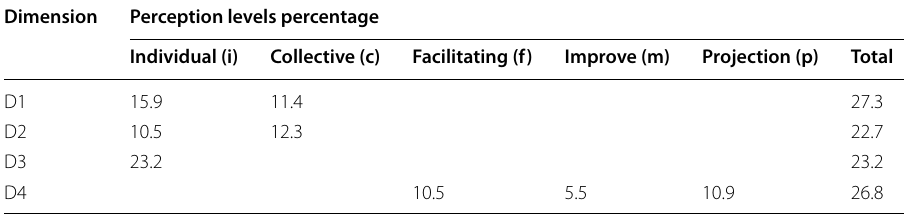
The scores represent the sum of percentages per level. Source: Authors’ elaboration